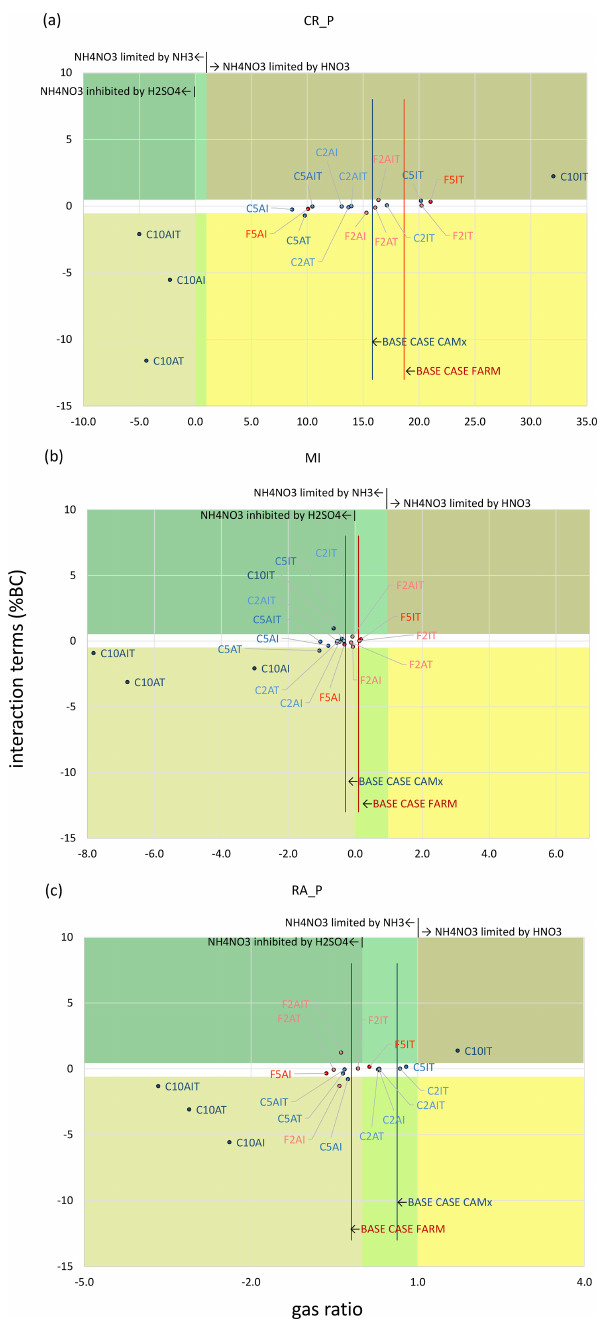
Figure 6. Plot of the interaction terms ( ˆ c ), expressed as a percentage of the base case (BC), in three selected sites with different chemical regimes versus the gas ratio (Ansari and Pandis, 1998). (a) CR_P: Cremona province, (b) MI: Milan and (c) RA_P: Ravenna province. C: CAMx and F: FARM. 10, 5 and 2 indicate 100%, 50% and 20% ERLs, respectively. A: agriculture, I: industry and T: trans- port. White background indicates negligible interaction